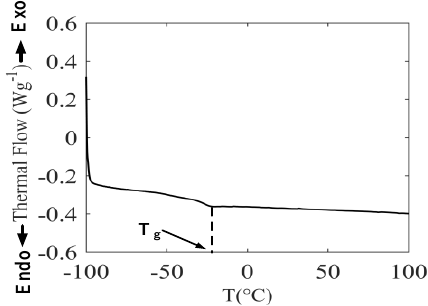
Figure 21. Determination of T g by di ff erential scanning calorimetry (DCS) method.